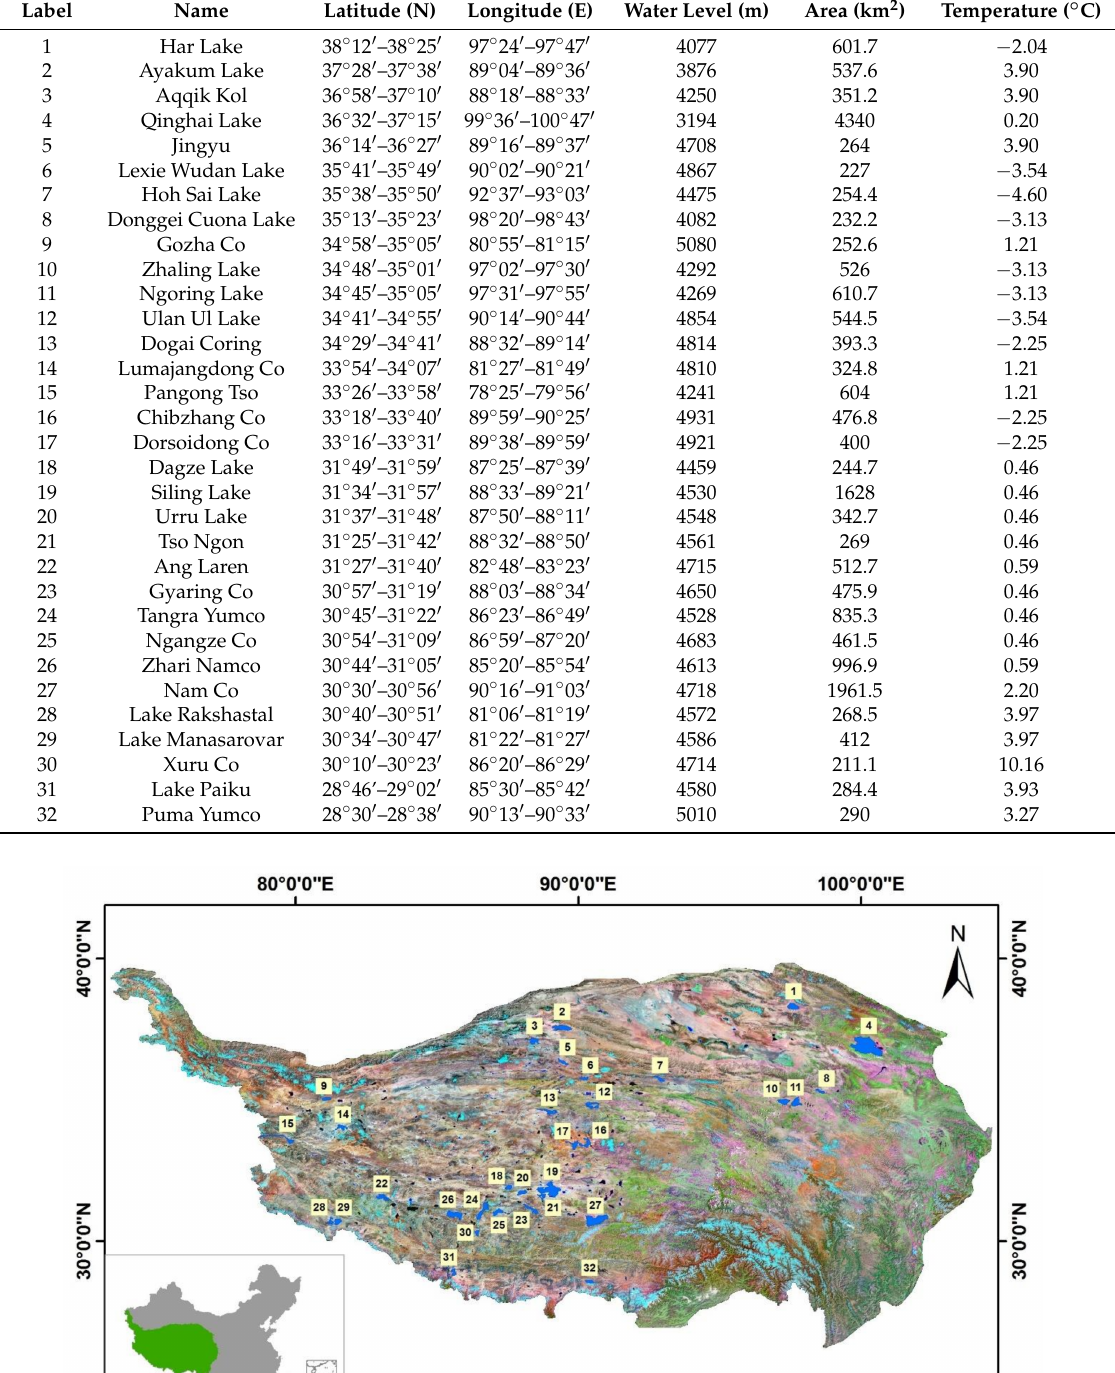
Table 1. Selected lakes in Tibetan Plateau. Latitude, longitude, water level, and area were obtained from Wang and Dou [35]. Annual mean temperature is based on the nearest meteorological station from the China Meteorological Data Service Center (CMDC).